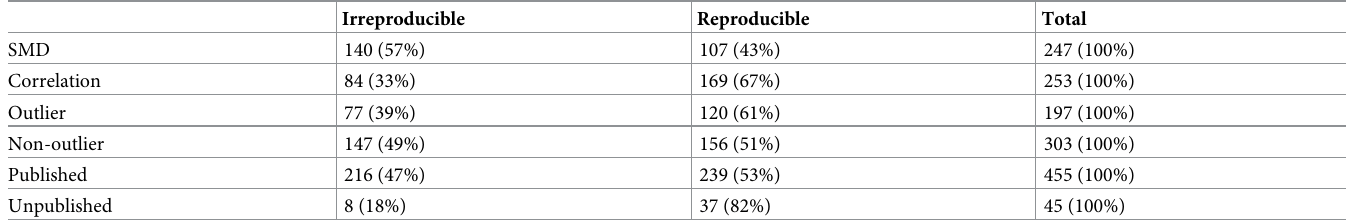
Table 2. Reproducibility frequencies separated by primary study characteristics.